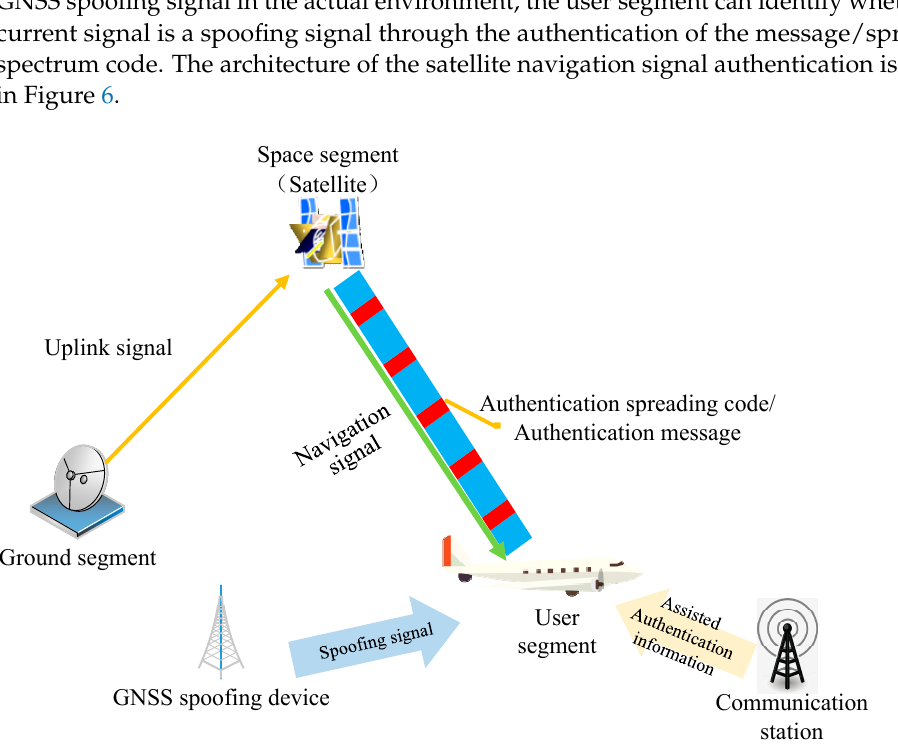
Figure 6. Satellite navigation signal authentication architecture.